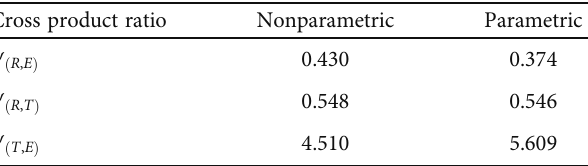
Table 3: Bi-variate cross product ratios.